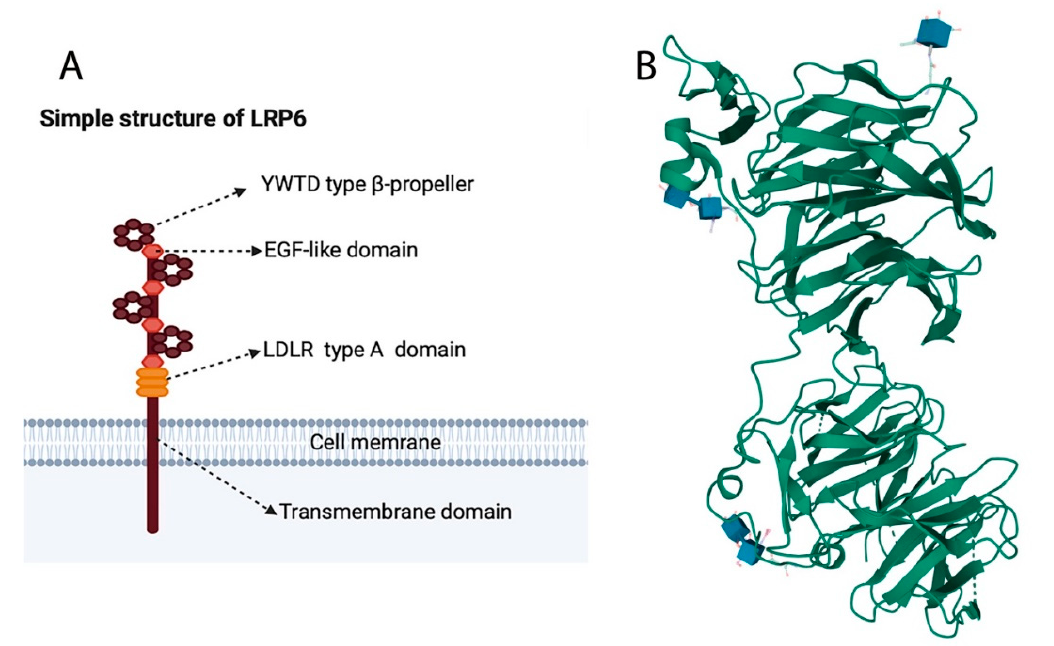
Figure 2. Structure of LRP6. ( A ) LRP6 consists of four YWTD β -propeller domains, each of which is followed by an EGF-like domain, and this is followed by three LDLR type A repeats, a transmembrane domain, and a short intracellular domain. ( B ) This structure was modelled using PDB protein databank software with ID number 3S94 according to the crystal structure of LRP6–E1E2, with green representing YWTD domains. This 3D structure of human LRP6 protein covers 37% of the sequence (585 residues from 21 to 628) with 100% confidence (Supplementary Figure S1), and it contains the binding site of Wnt members and some Wnt inhibitors such as DKK1.